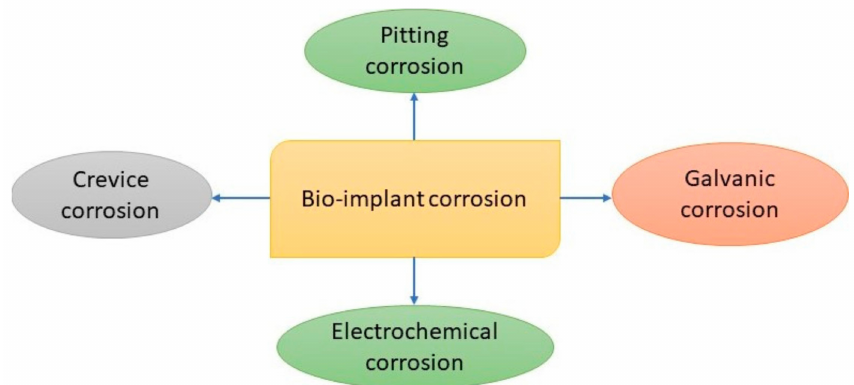
Figure 6. Basic types of corrosion behaviour induced in biomaterials.